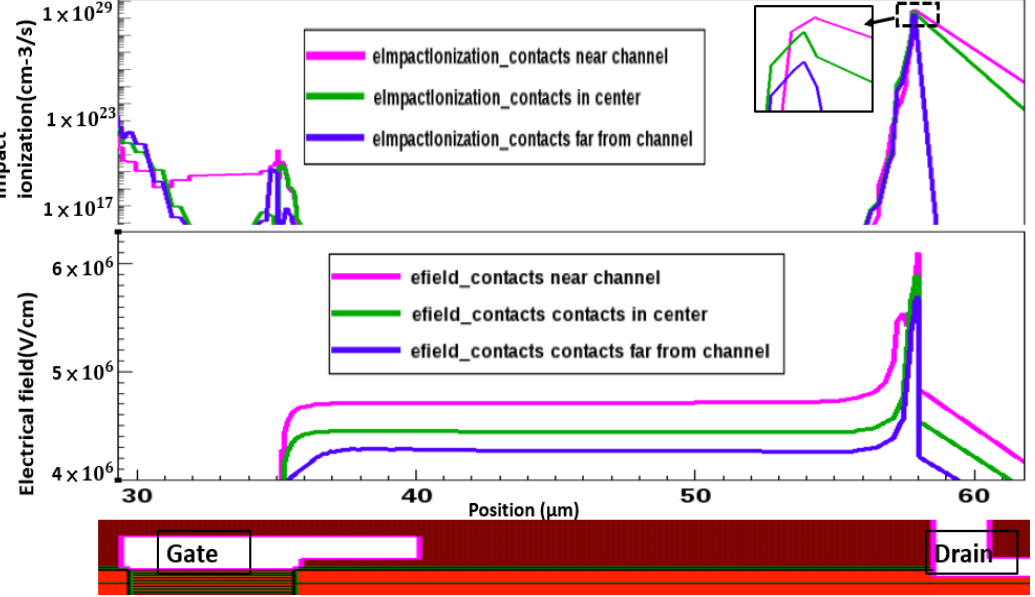
Figure 7. Impact ionization and electrical field profiles at breakdown for different metal contact positions.